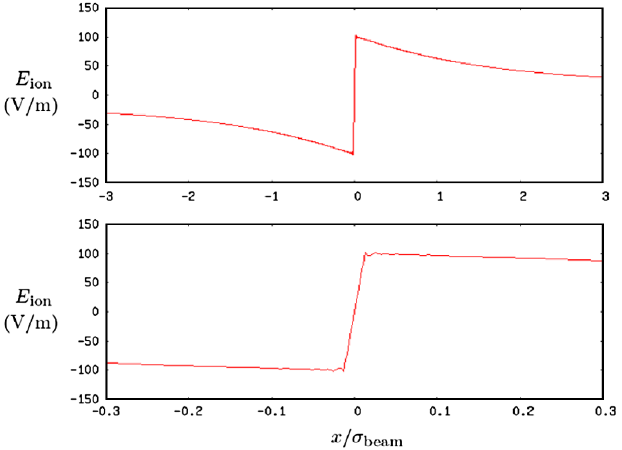
FIG. 6. (Color) Electric field produced by the ions at s (cid:5) (cid:10) 1 m in the 20 m beam model. Top and bottom show the same field on different transverse length scales.